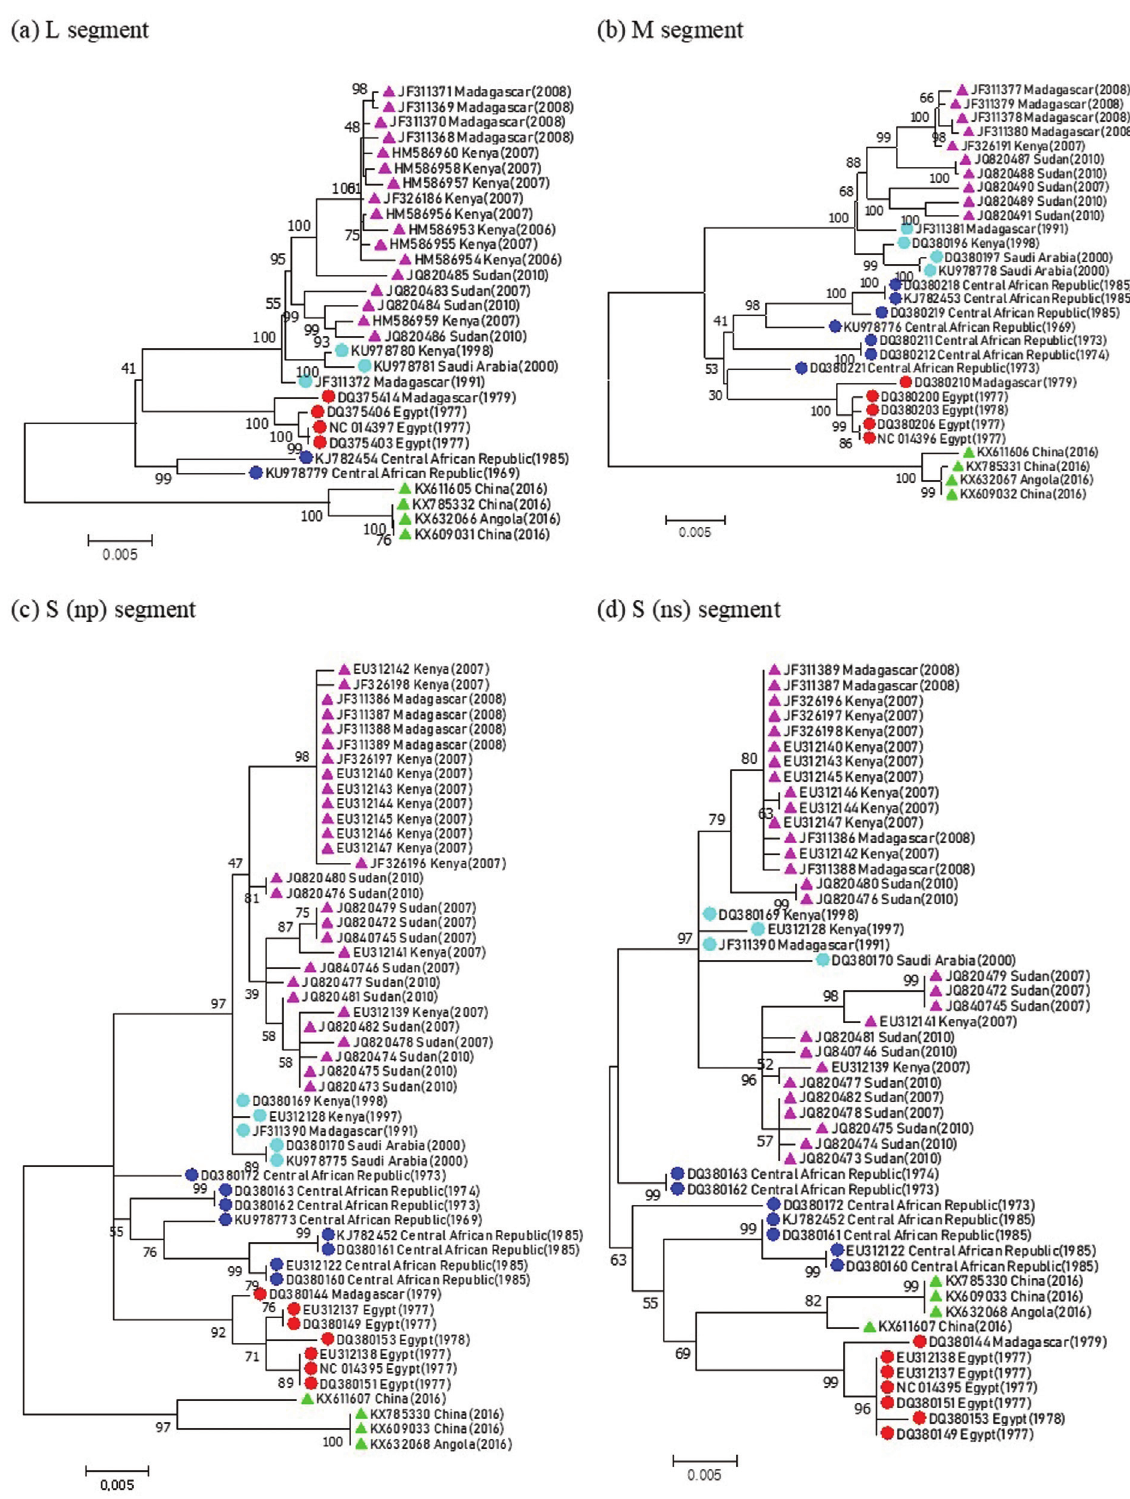
Figure 1 - Phylogenetic analysis of RVFV; (a) L segment, (b) M segment, (c) S (np) segment, (d) S (ns) segment RVFVs were classified into five groups (Group 1: [pink triangle]; Group 2: [sky blue circle]; Group 3: [dark blue circle]; Group 4: [red circle]; Group 5: [light green